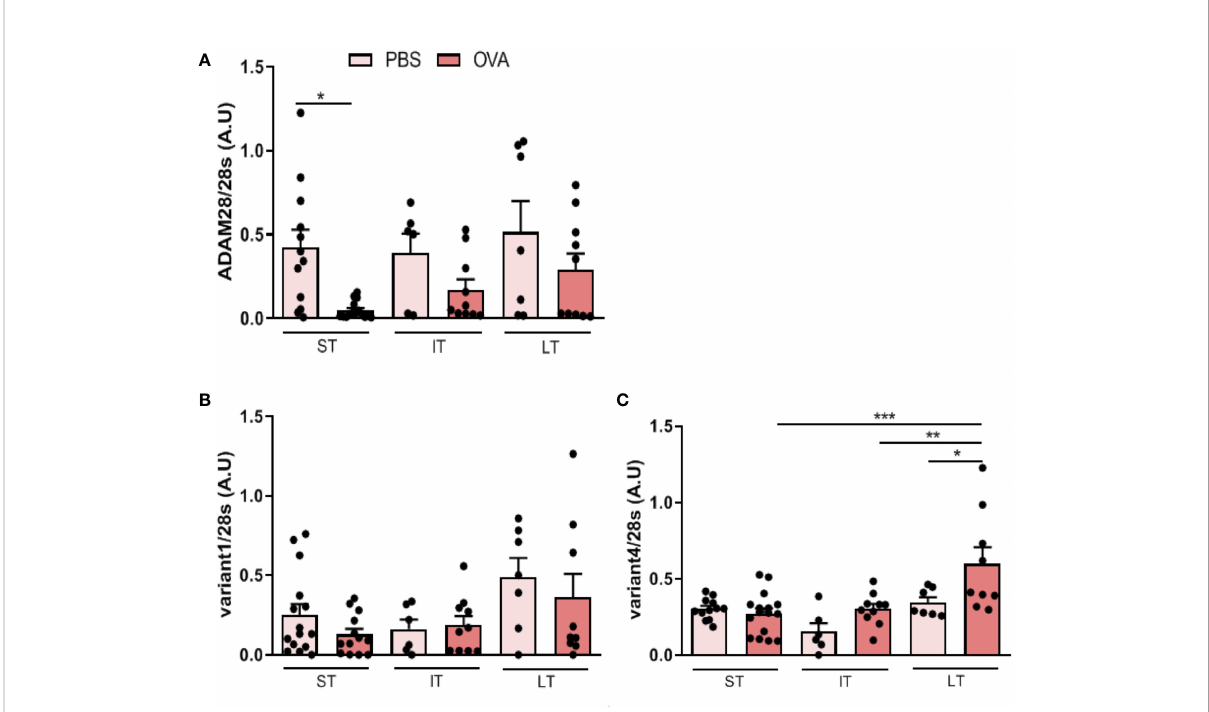
FIGURE 2 Effects of OVA exposure on ADAM28 RNA expression in the lung of mice assessed by RT-PCR on RNA extracted from lungs of mice exposed and non-exposed to OVA. Results are normalized to the 28s rRNA RT-PCR. (A) Quanti fi cation of relative total ADAM28 mRNA expression in lung of mice (N=2; PBS-ST n=12, OVA-ST n=15, PBS-IT n=6, OVA-IT n=10, PBS-LT n=7, OVA-LT n=10), (B) membrane-bound ADAM28 (Var1) mRNA expression (N=2; PBS-ST n=15, OVA-ST n=13, PBS-IT n=6, OVA-IT n=10, PBS-LT n=7, OVA-LT n=9), (C) secreted (Var4) ADAM28 mRNA expression (N=2; PBS-ST n=12, OVA-ST n=16, PBS-IT n=6, OVA-IT n=10, PBS-LT n=7, OVA-LT n=9). Results are represented as the mean ± SE, . *p<0.05, **p<0.01, ***p<0.001 (one-way